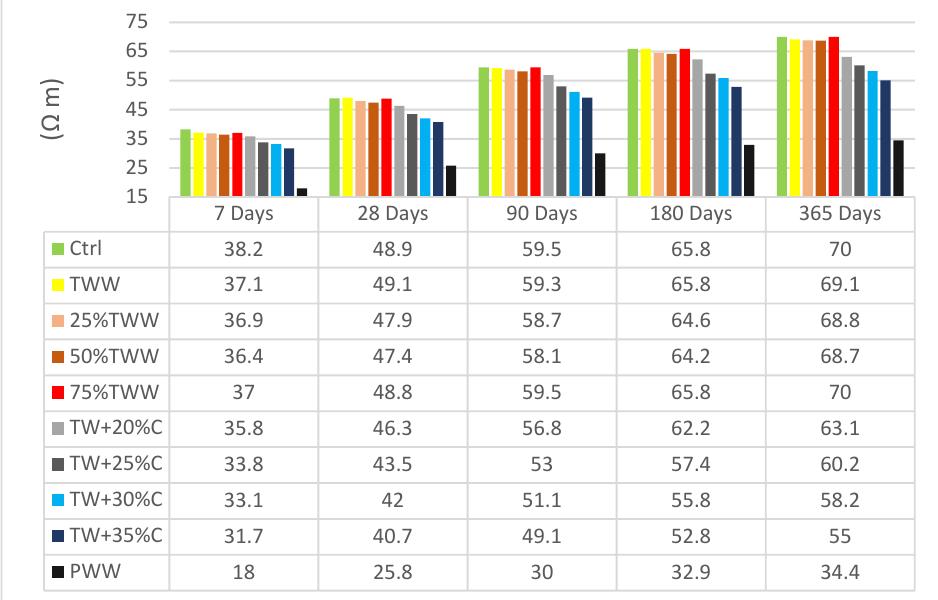
Figure 6. The results of concrete electrical resistivity tests cured by TWW. At the age of 28 days, TW + 30%C, cured by drinkable and treated wastewater, had 15% and 14% less electrical resistivity than the control sample, respectively. This indicated that using wastewater in concrete has more negative effects on the concrete’s durability features than on its strength, because it had 10% reductions in the compressive strength test but a 15% reduction in electrical resistivity. Therefore, it is recommended that treated wastewater should not be used for projects with high contact with caustic material or marine